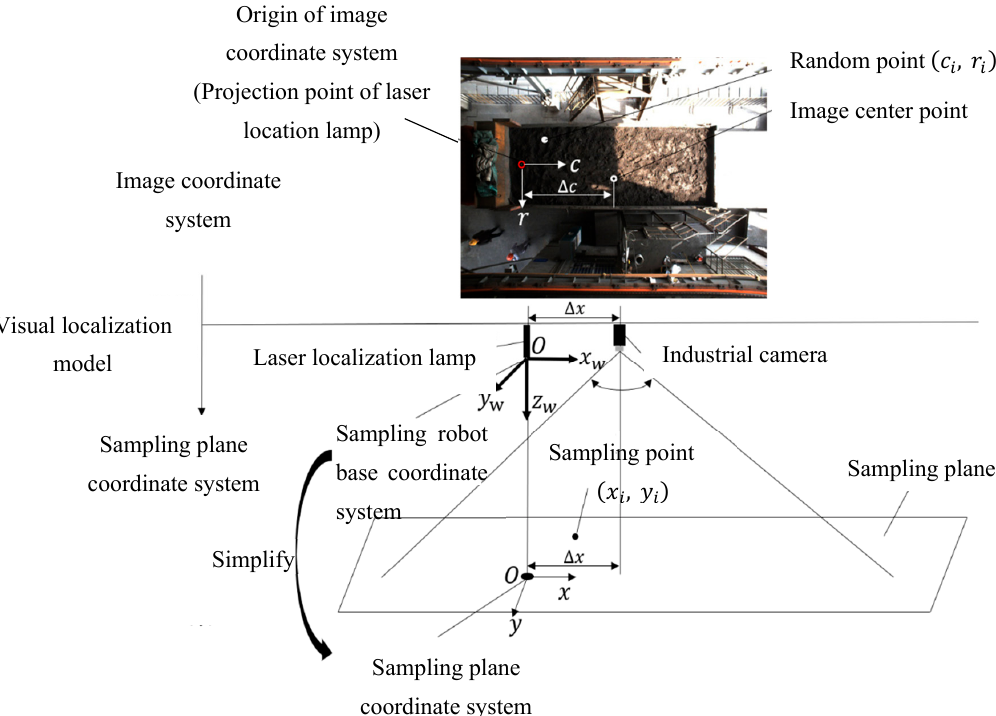
Figure 16. Schematic diagram of the visual localization model.